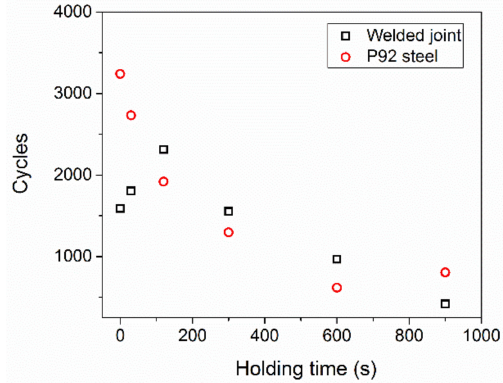
Figure 4. Cyclic life of CF specimens (P92 steel and welded joint) with different holding